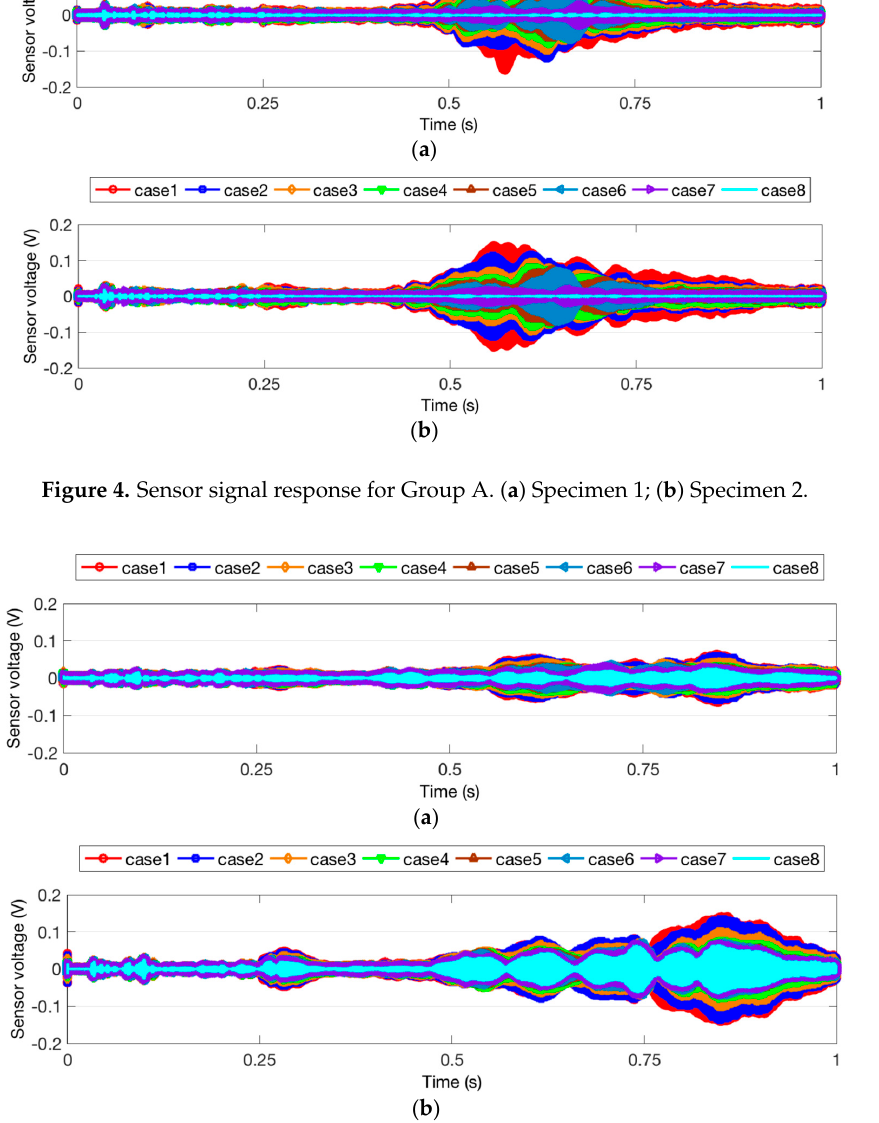
Figure 5. Sensor signal response for Group B. ( a ) Specimen 3; ( b ) Specimen 4.